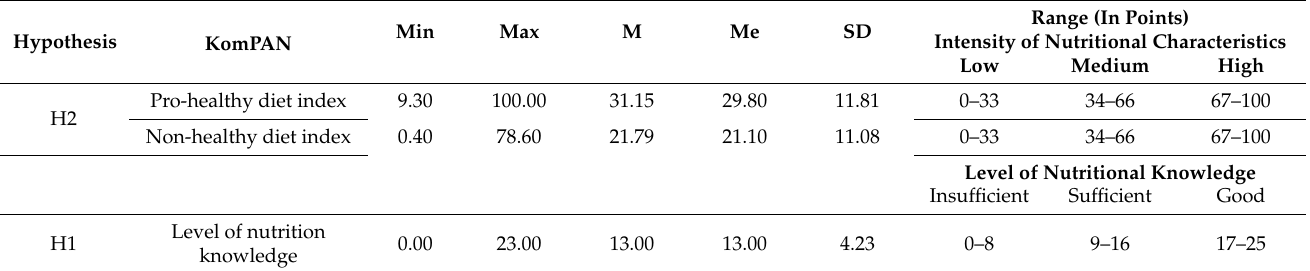
Table 2. Indexes of diet quality and the level of nutrition knowledge in the general group of participants.